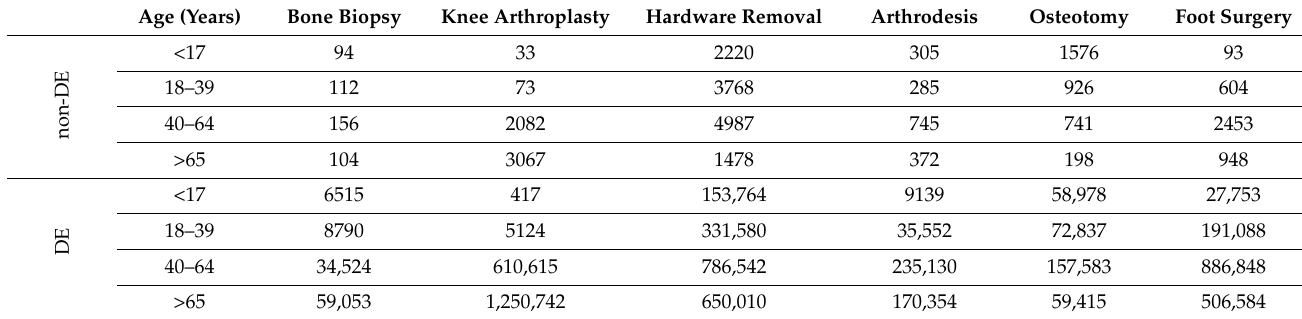
Table 5. Total count for orthopedic procedures per age